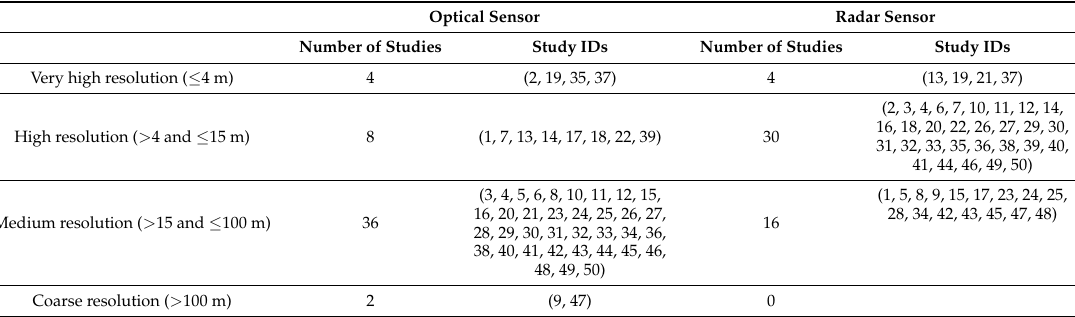
Table 3. Spatial scale (image resolution) at which images were acquired in studies including land use assessments. For studies with multiple input data, the coarsest scale is reported. Radar image resolutions refer to ground resolution after multi-looking and projecting acquired scenes. Where studies did not specify scales, the most common scales at which images from the sensors used are acquired were